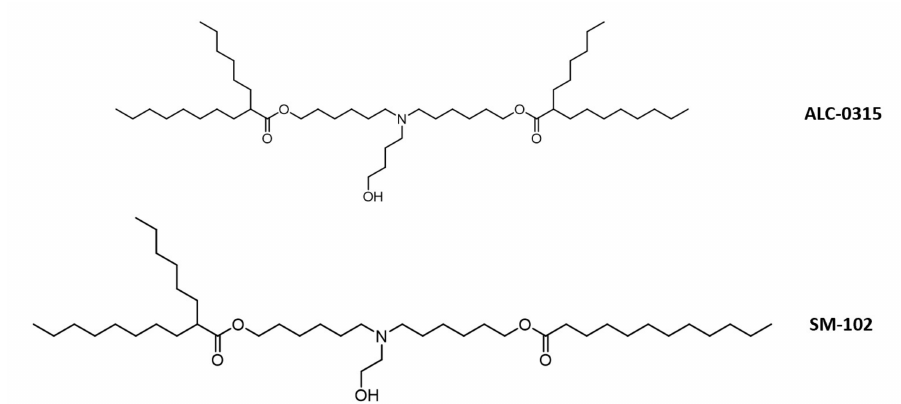
Figure 5. Chemical structure of two most advanced LNP that assisted in delivery of 2 mRNA COVID vaccines. ALC-0315 and SM-102 contains similar structure with ethanolamine head (one is shorter than others). ALC-0315 has two branched degradable ester tail, while SM-102 only has one branched ester